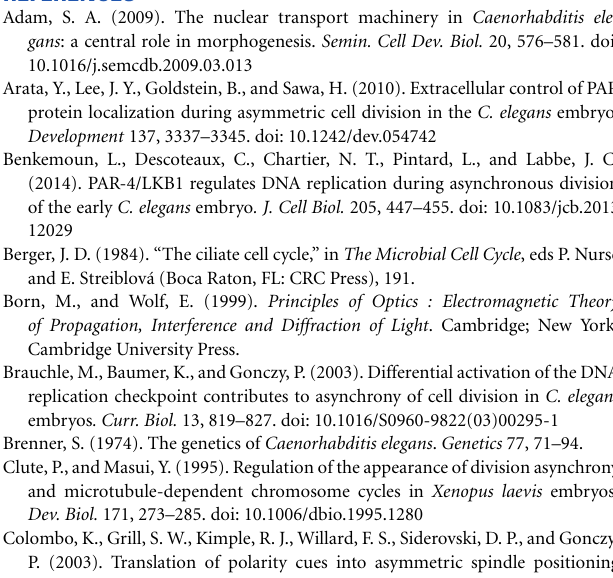
Figure S1 | Integral approach for measuring cell volume. (A) Serial images of an embryo at the four-cell stage along the Z-axis at 3- μ m intervals. The image at 0 μ m was at the closest side of the embryo to the objective lens. The focus position moved to the farther side of the embryo in an upright microscope. Cell contours were shown as blue circles, which were traced by following the cell periphery and granules in focus located around the cell boundary. (B) Three-dimensional reconstruction of an embryo in the two-cell stage from serial images obtained along the Z-axis at 0.5- μ m intervals using Image J. In the reconstructed image in the X-Z axis, nuclear peripheries are indicated by black dots. Figure S2 | Statistical analyses to select a model to explain the T–V relationships in C. elegans . Relationship between cell cycle duration and cell volume in AB (A) , MS (B) , C (C) , P (D) , E (E) , and D (F) lineages in the linear scale was fitted by three different models: Gaussian, exponential, or power law function by the Levenberg-Marquardt algorithm, using the same data used in Figure 2 . Fitted functions and χ 2 -values are shown in the boxes. Figure S3 | Size asymmetry between daughter cells in C. elegans C lineage. Diagram shows the cell division pattern in C lineage. Anterior and posterior daughters are indicated as “a” and “p,” respectively. The cell sizes were observed in serial images along the Z-axis, and are shown at the Z axis plane, where the nuclei are located in focus with blue circles. Cell division of Ca, Caa, Cp, and Cpa was asymmetric in the daughter cell sizes, in which the anterior daughter was larger than the posterior daughter. Cpa and Cpp were located in different Z-planes in an embryo. Scale bar = 10 μ